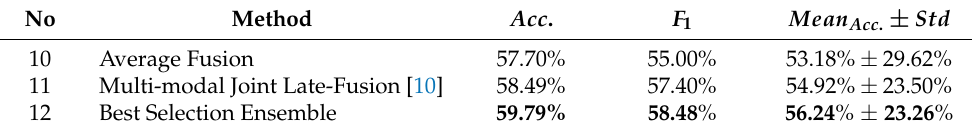
Table 5. Validation results of the ensemble experiments on the AFEW validation set. No Method Acc . F 1